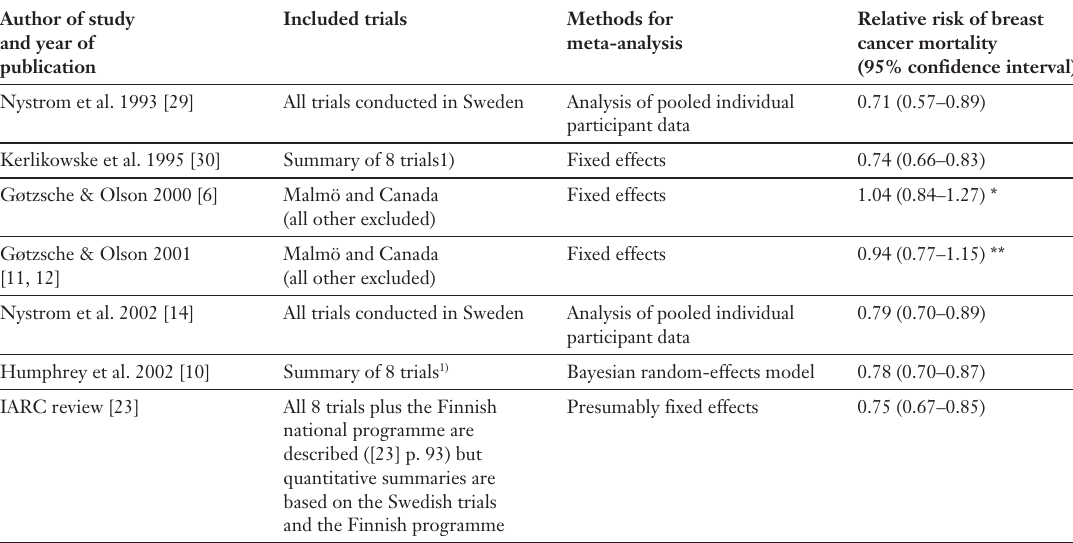
Table 5 Systematic reviews of randomised trials of screening mam- mography among women over 50 and efficacy estimates for follow-up of at least 10